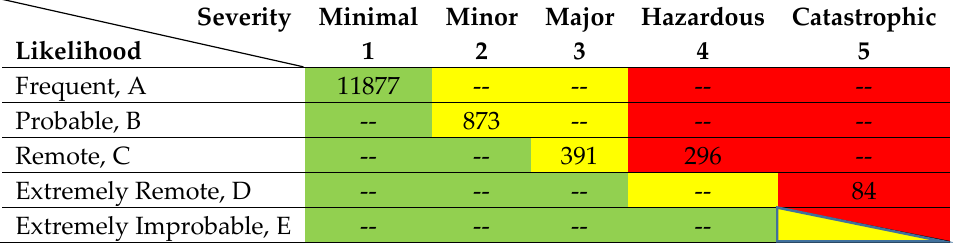
Table 13 . Risk matrix with look-ahead time 60 s, head-to-head scenario. Table 13. Risk matrix with look-ahead time 60 s, head-to-head scenario.